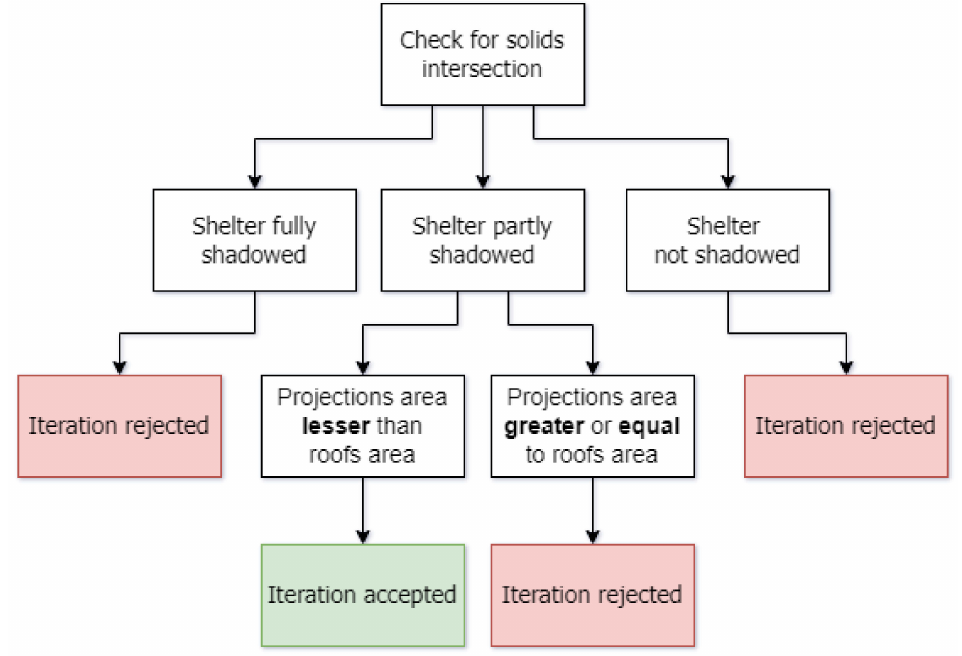
Figure 21. Diagram showing various scenarios of spatial analysis taken into account depending on the type of relationship between the solids of shadows cast by buildings and the roofs.